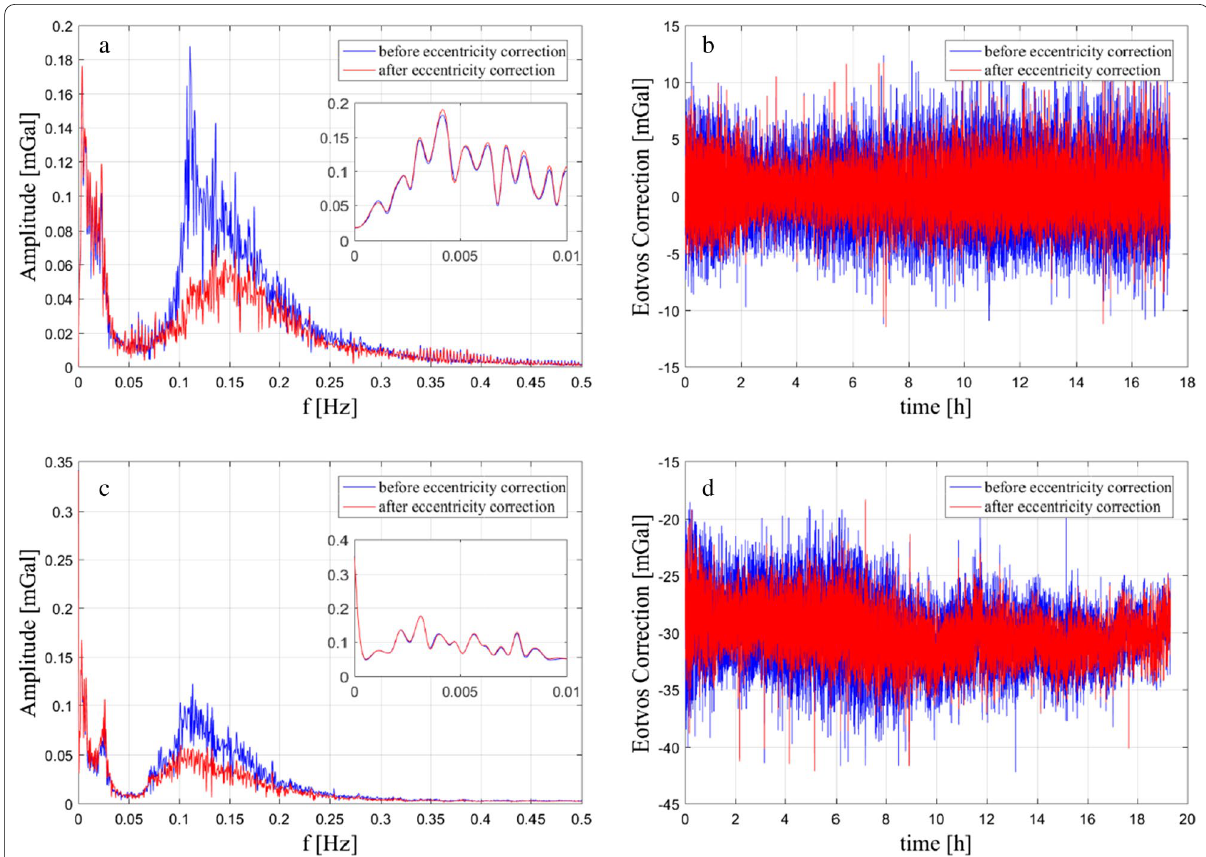
Fig. 13 Fourier time–frequency analysis of Eötvös corrections. a and c are the single-sided amplitude spectra of the Eötvös corrections of S1-1 and X1-1, respectively; the small windows are enlarged views of the low-frequency band. b and d are the corresponding time-domain Eötvös corrections